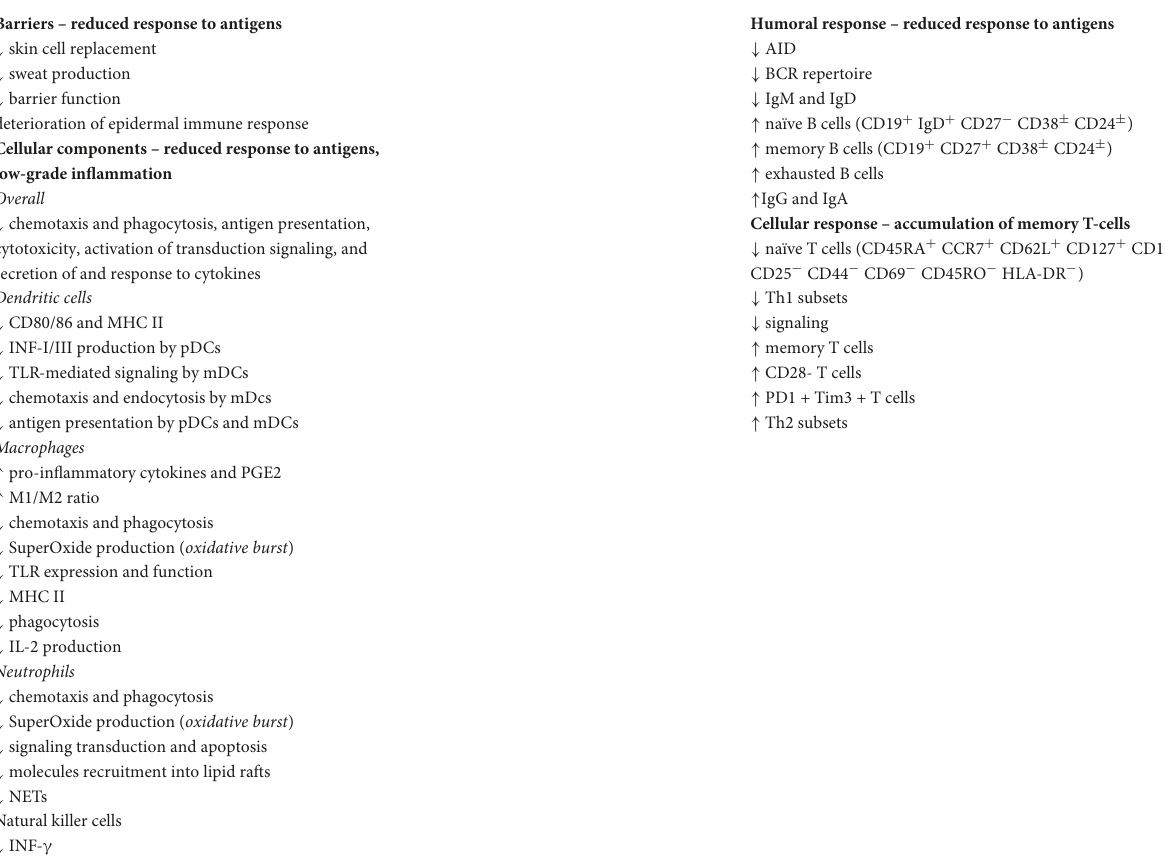
TABLE 1 Summary of effects of aging on innate and adaptative immune systems. Senescent innate immune system Senescent adaptative immune